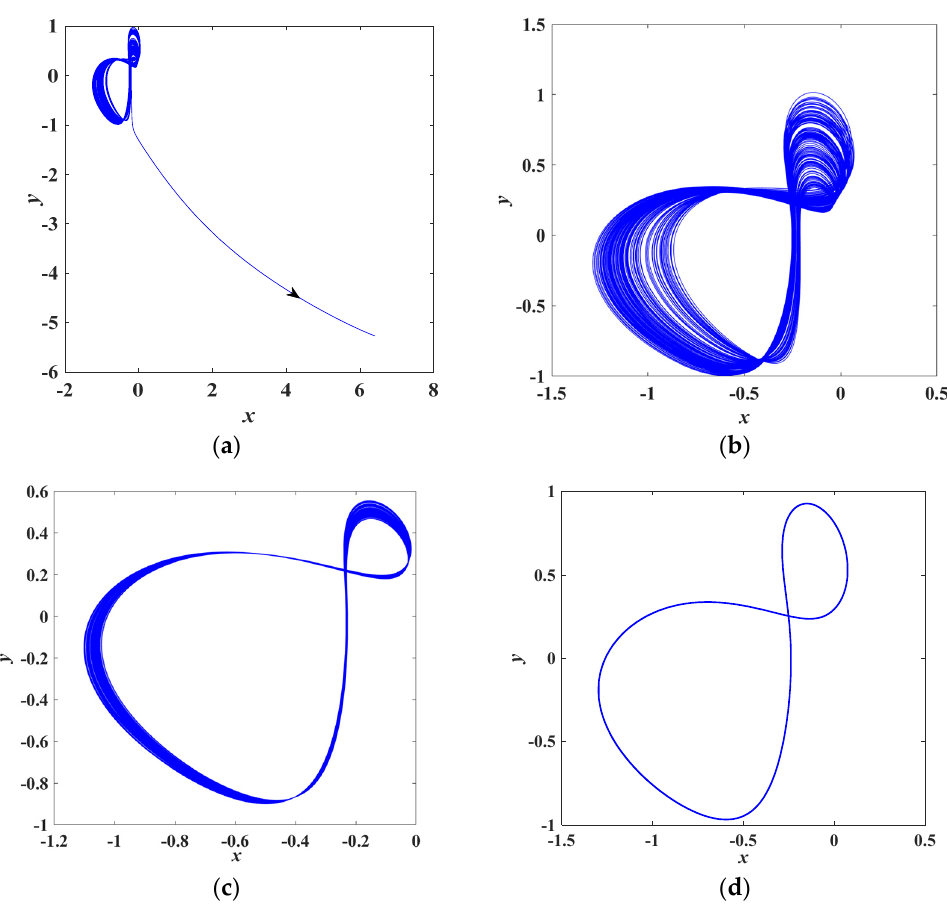
Figure 13. Phase portraits of the HNN under the parameter c 2 = 5.68, 5.76, 5.82, 6: ( a ) c 2 = 5.68; ( b ) c 2 = 5.76; ( c ) c 2 = 5.82; ( d ) c 2 = 6.